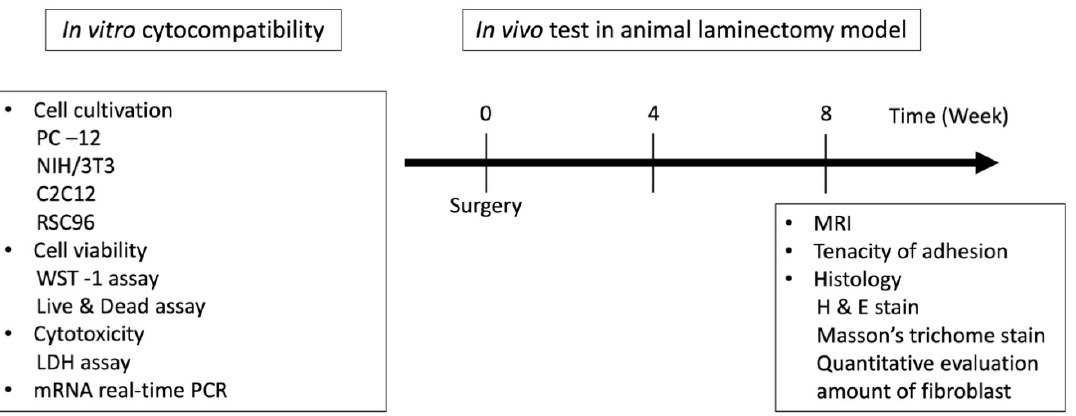
Figure 2. Experimental setup. The cytocompatibility of the sponge was tested, and its effect on epidural fibrosis in a rat model after laminectomy was